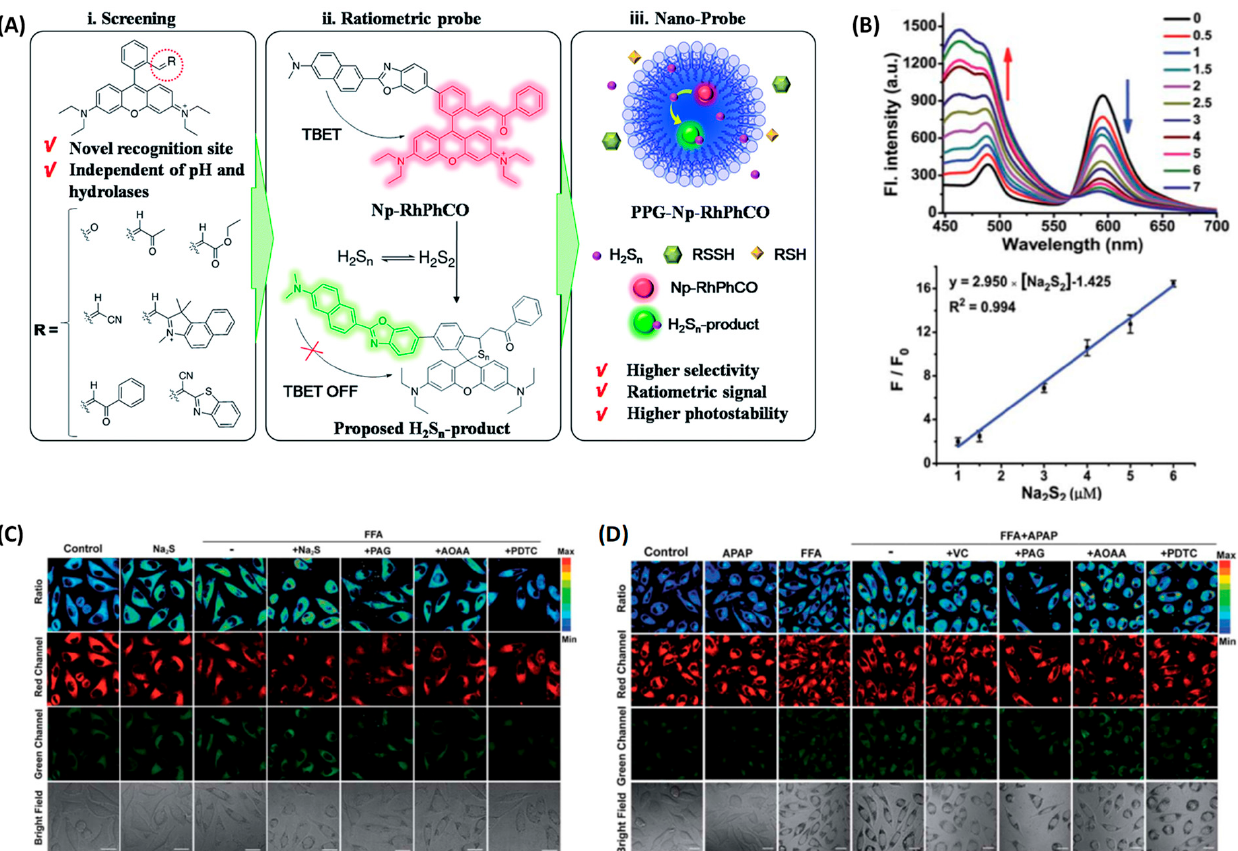
Figure 15. ( A ) Design strategy of the ratiometric fluorescent probe PPG − Np − RhPhCO for sensing H 2 Sn. ( B ) Up: Fluorescence spectra of PPG − Np − RhPhCO in the presence of various concentrations of Na 2 S 2 in PBS buffer (pH 7.4). Down: Plot of fluorescence intensity ratio (I 486 /I 594 ) changes as a function of Na 2 S 2 concentration in PBS buffer (pH 7.4). ( C ) H 2 Sn imaging in NAFLD with the nano-probe PPG − Np − RhPhCO. ( D ) H 2 Sn imaging in drug-treated NAFLD. [45] Copyright © 2023 Royal Society of Chemistry.